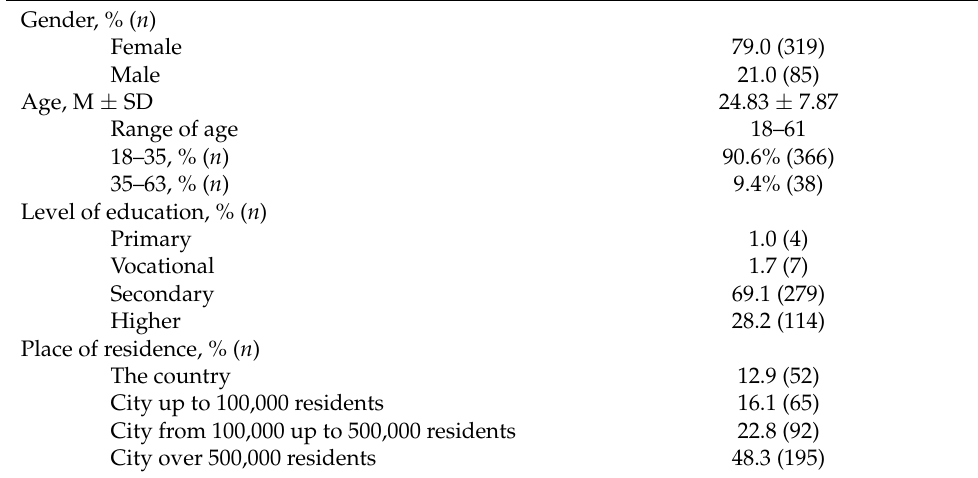
Table 2. Characteristic of participants ( n =